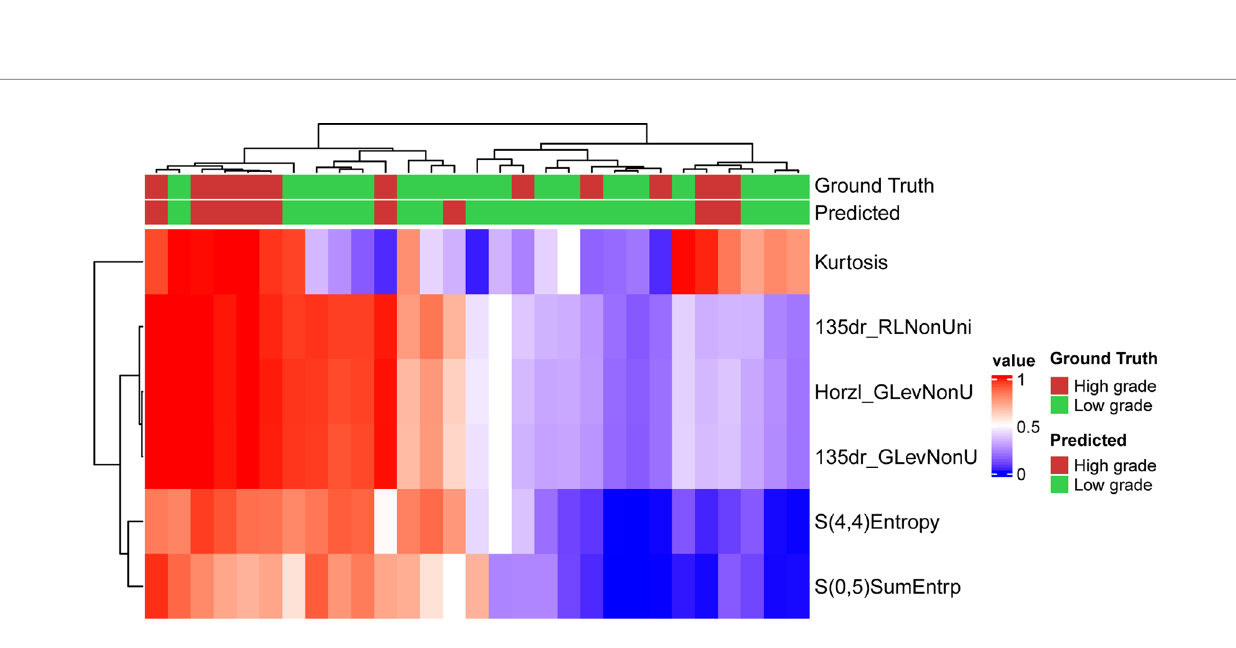
FIGURE 4 | Prediction result and the heatmap of the selected 6 features in the validation set along the clustering results of the samples and the features.